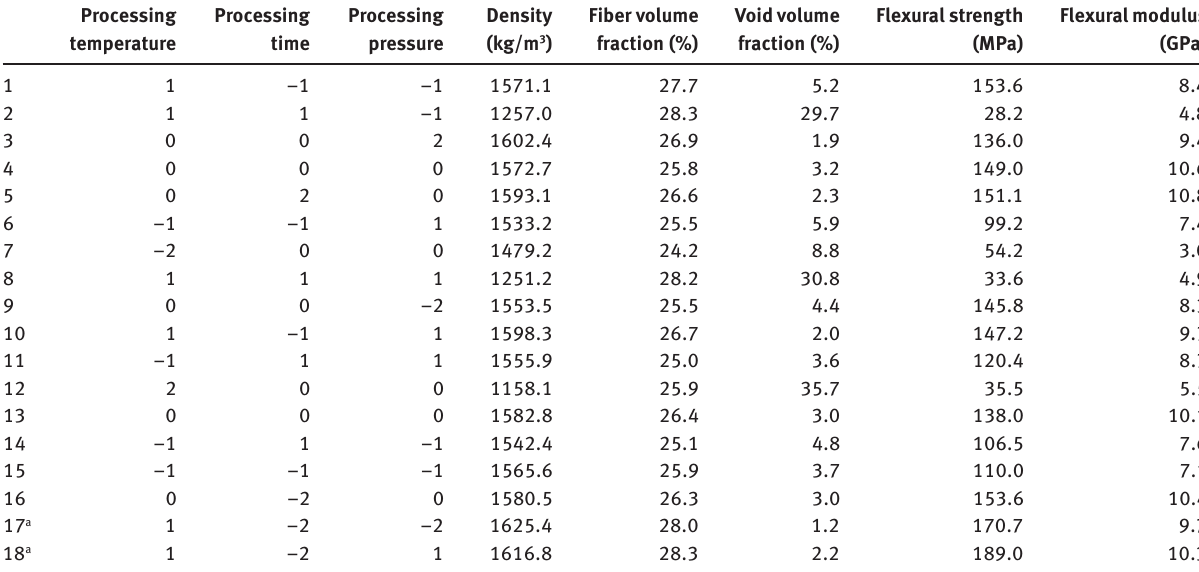
Table 2: Average flexural strength and modulus of the PVC/glass fiber composite laminates.